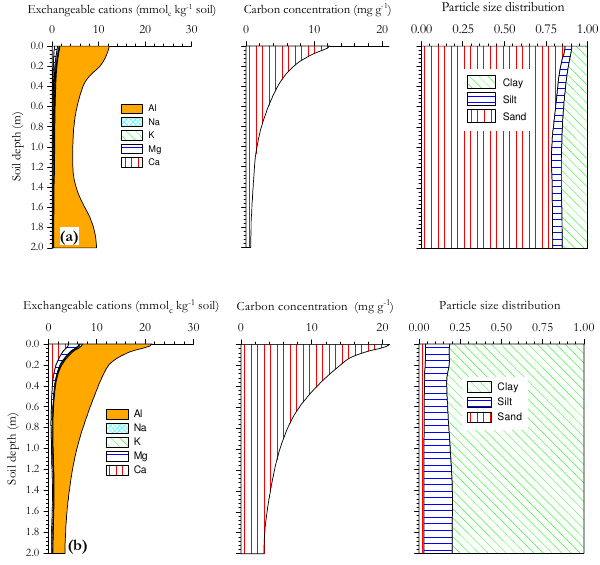
Fig. 9. Profiles of exchangeable cations, soil carbon and tex- Fig. 9 ture: (a) for a Geric Acric Ferralsol (Alumic, Hyperdystric, Arenic) at Mato Grosso state, Brazil (SIN-01) and (b) for a Gibbsic Geric Ferralsol (Alumic, Hyperdystric, Clayic, Xanthic) at Amap´a state, Brazil